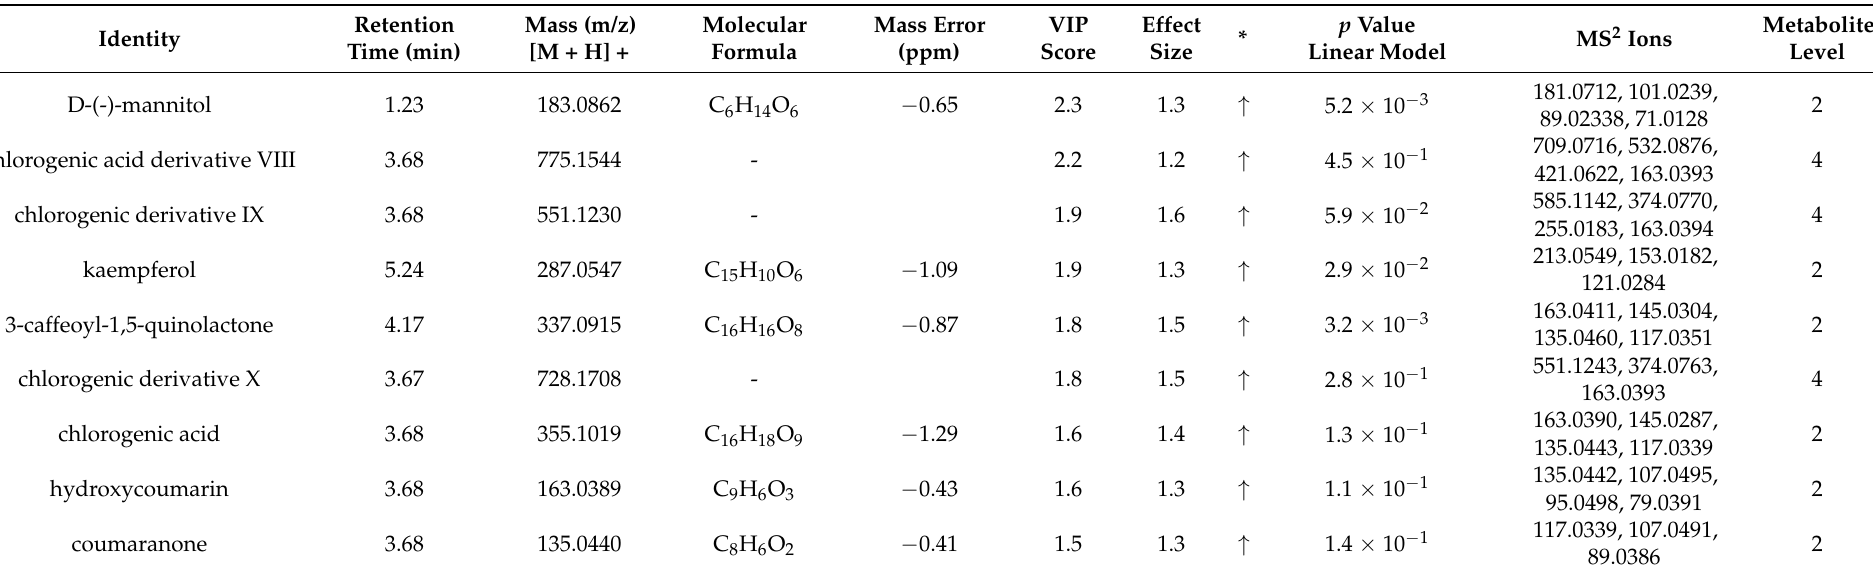
Table 3. Metabolites identified in UHPLC-HRMS ESI+ data that were significant (VIP > 1.5) in the OPLSDA model between RV HIGH compared to RV LOW apple spur buds with associated effect size. P values indicate those metabolites that are significant in the linear model with the (y ~ returnbloom) for RV LOW , RV MID and RV HIGH